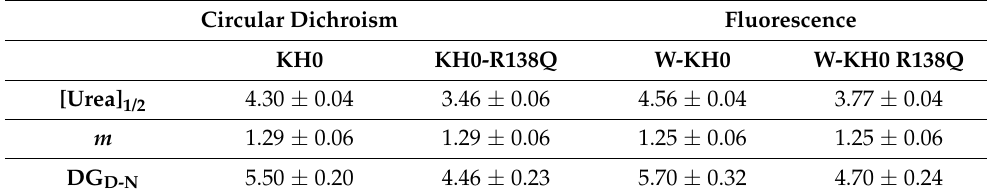
Table 1. Urea-induced thermodynamic parameters obtained by fluorescence and circular dichroism equilibrium experiments. The m parameter was shared between the data sets of the non-fluorescent variants in the CD-monitored denaturations, between the fluorescent variants in the fluorescence- monitored denaturations and between the data sets of the fluorescent variants in the fluorescence-